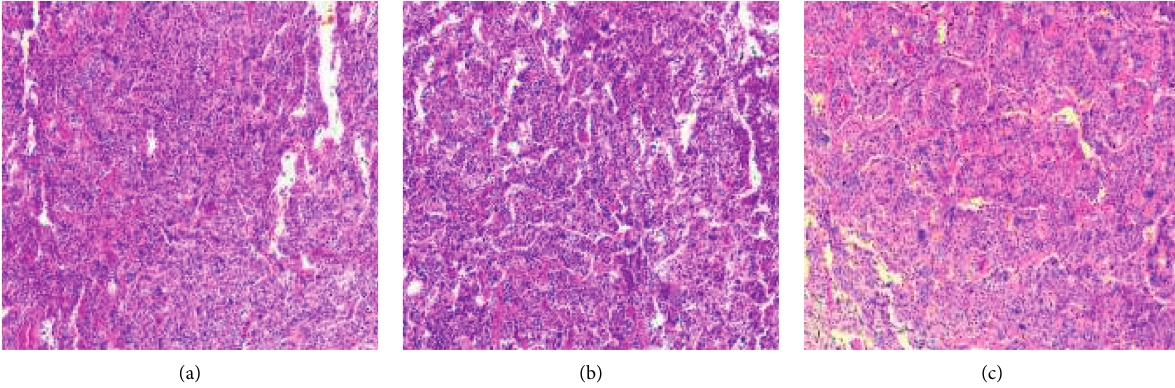
Figure 2: Biopsy analysis at 50%. The histologic section showing fragments of a hypercellular neoplasm with mixed solid and papillary architecture. The tumor cells demonstrate moderate to marked nuclear pleomorphism. Scattered mitotic activity is